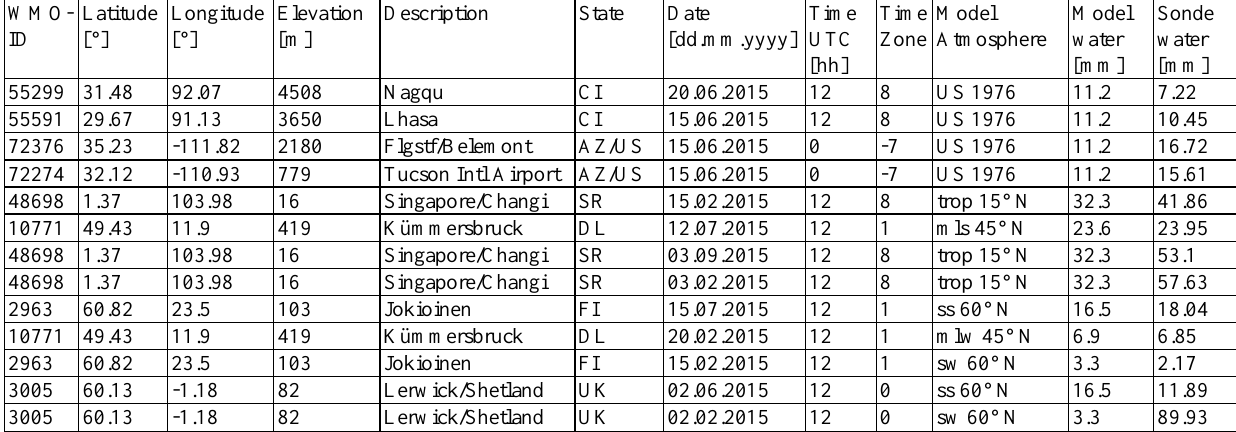
Table 1. Radiosonde sites sorted by increasing refractive displacement at 10 km camera